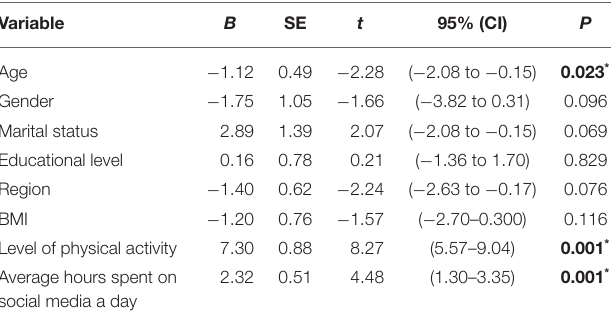
TABLE 3 | Predictors associated with attitudes of physically active individuals toward the use of social media.